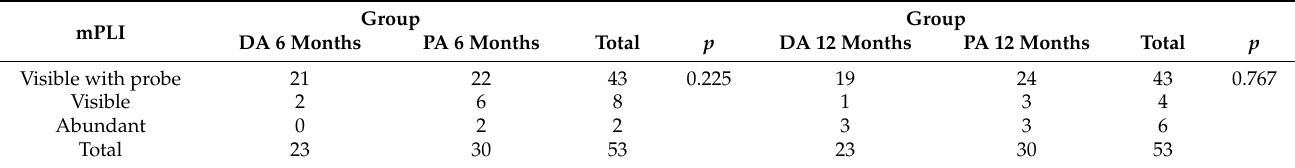
Table 3. Modified Plaque Index, 6 and 12